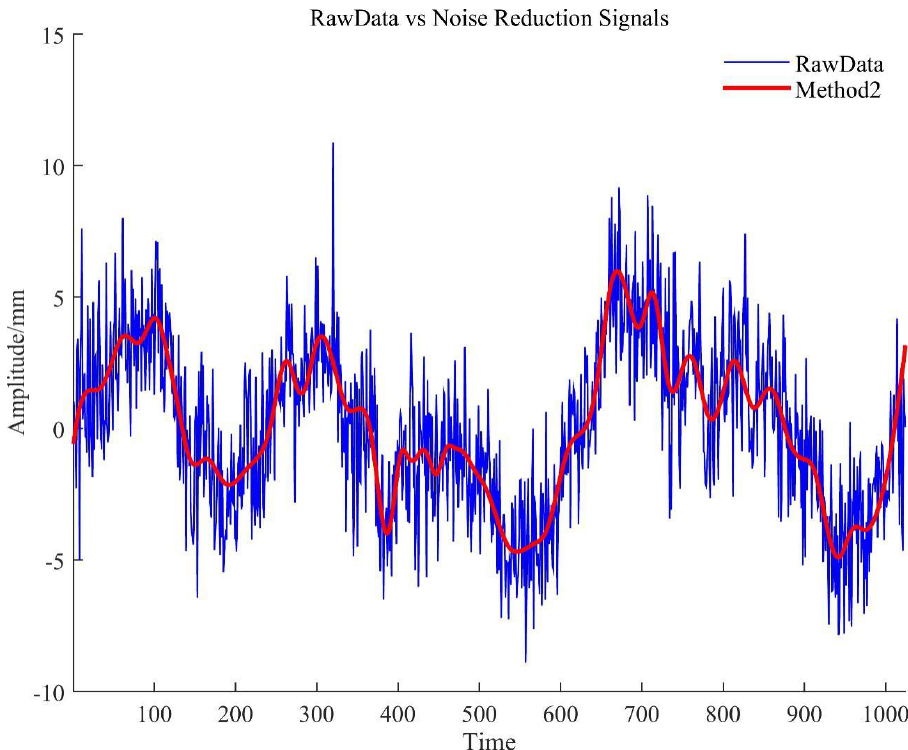
Figure 12. Result of noise reduction with method of simulation data I.